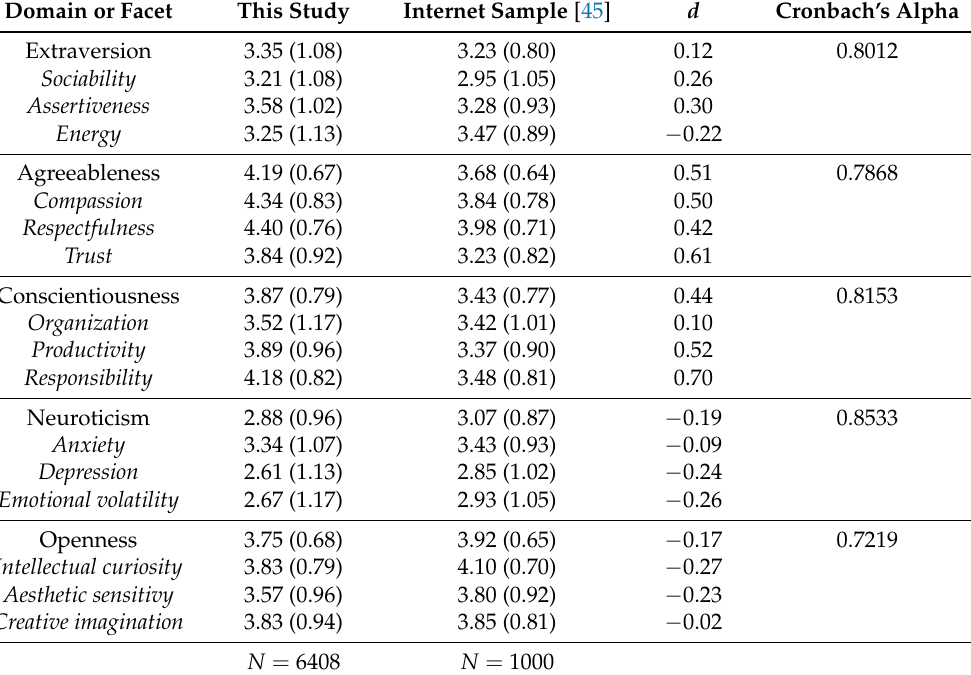
Table A1. Mean and standard deviation of the BF traits and facets in this study vs. the Internet sample [45]. The fourth column shows the mean-level difference d between the two samples. The last column represents the Cronbach’s alpha of each item scale that measures a BF trait.